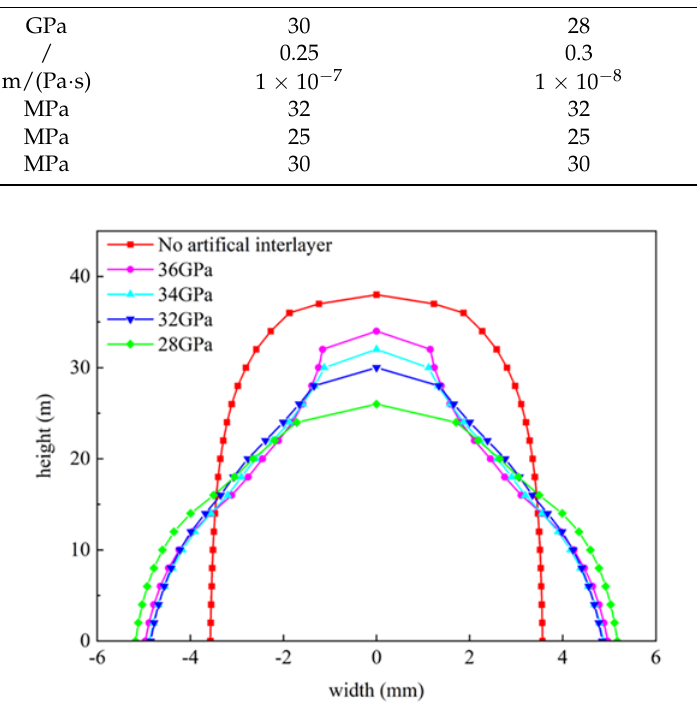
Figure 8. Fracture morphology at different Young’s modulus of artificial barrier.